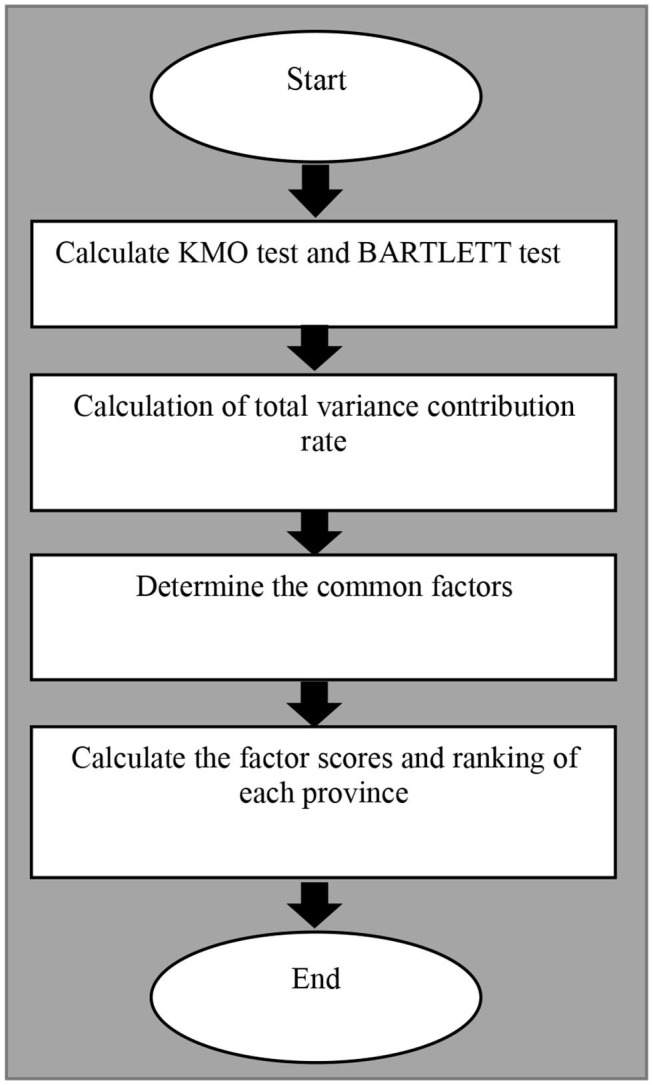
The measurement steps of factor analysis.